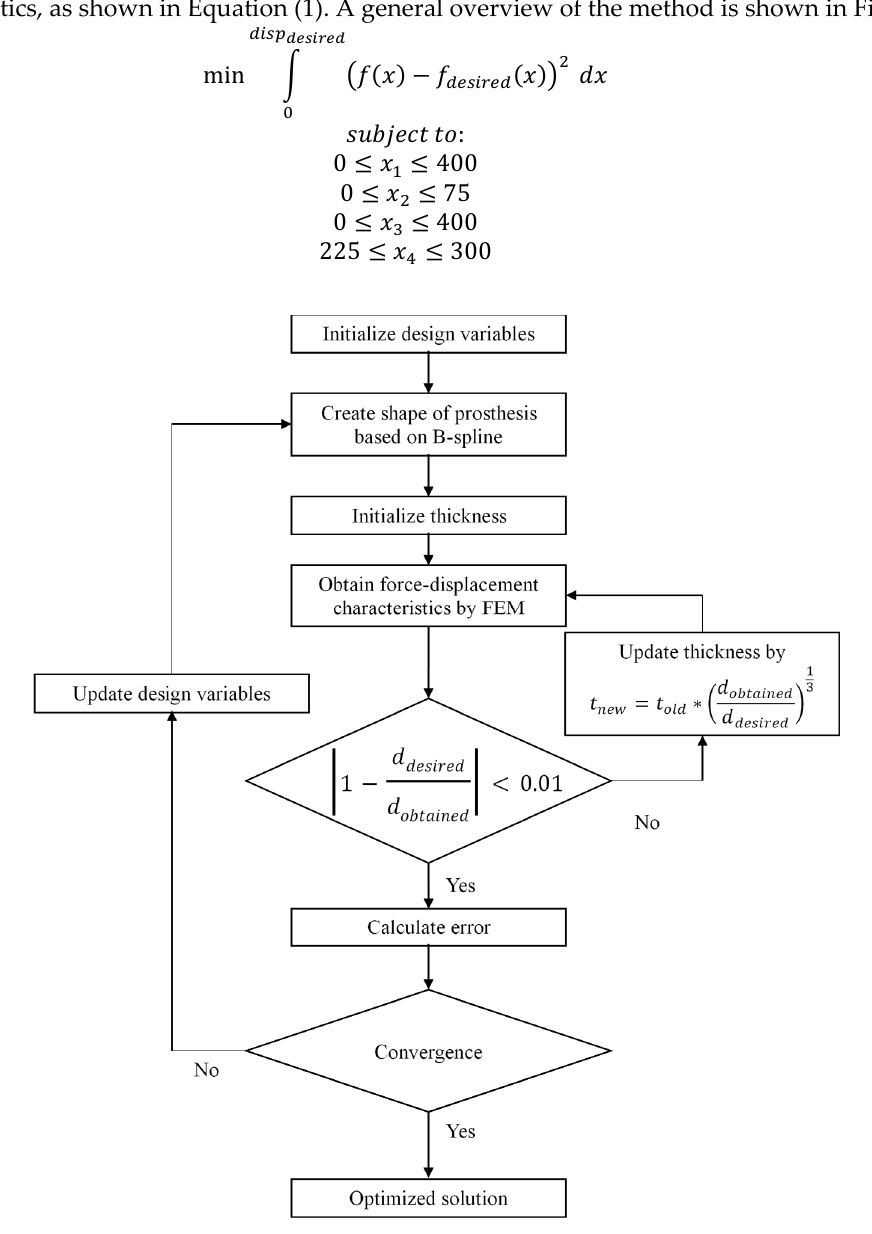
Figure 3. The overall procedure of shape optimization of prosthesis based on force-displacement